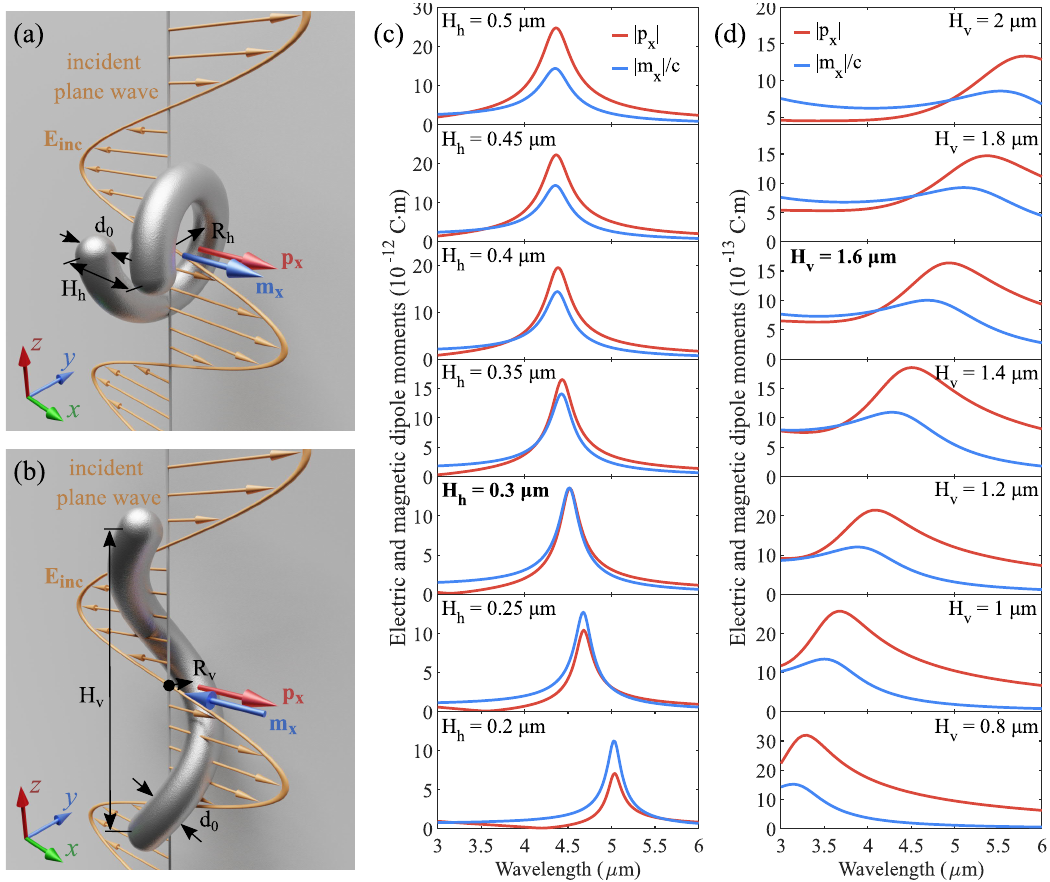
Figure 1. ( a , b ) Illustration of horizontally-oriented and vertically-oriented single-turn helices with the following structural parameters: R h = 0.27 µ m, H h = 0.3 µ m, R v = 0.15 µ m, H v = 1.6 µ m, d 0 = 0.16 µ m. ( c , d ) Wavelength dependence of electric and magnetic dipole moments under the parametric scan of the helix